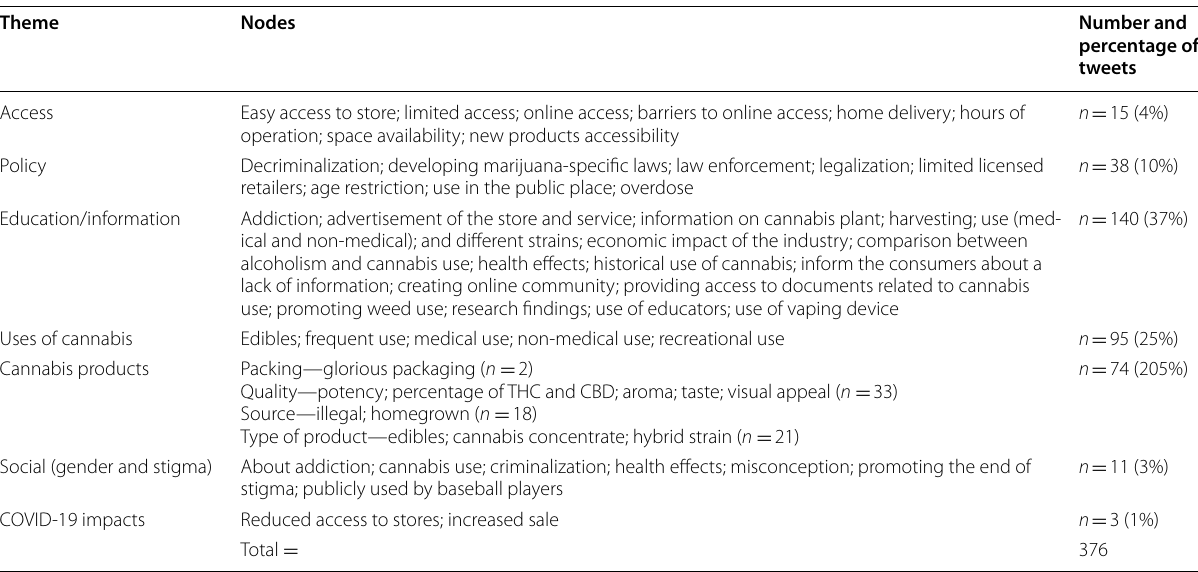
Table 3 Themes and nodes in unlicensed cannabis retailers Theme Nodes